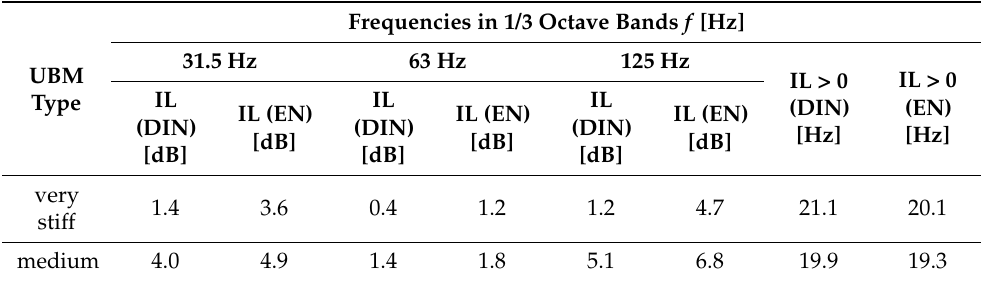
Table 11. Suppression of the vibration level: insertion loss values obtained for two UBM samples from the 4-DoF mechanical model in 1/3 octave